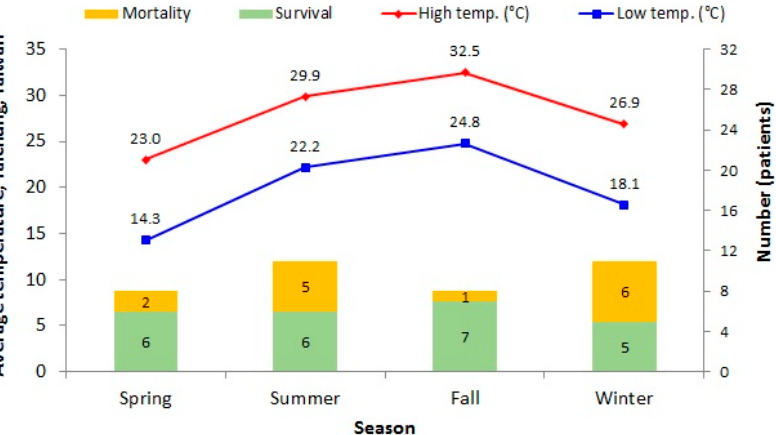
Figure 2. Seasonal variations between average air temperature and patient distribution in each season (P = 0.226). (Green: survival patient numbers; Yellow: mortality patient numbers; Red: average high temperature; Blue: average low temperature).